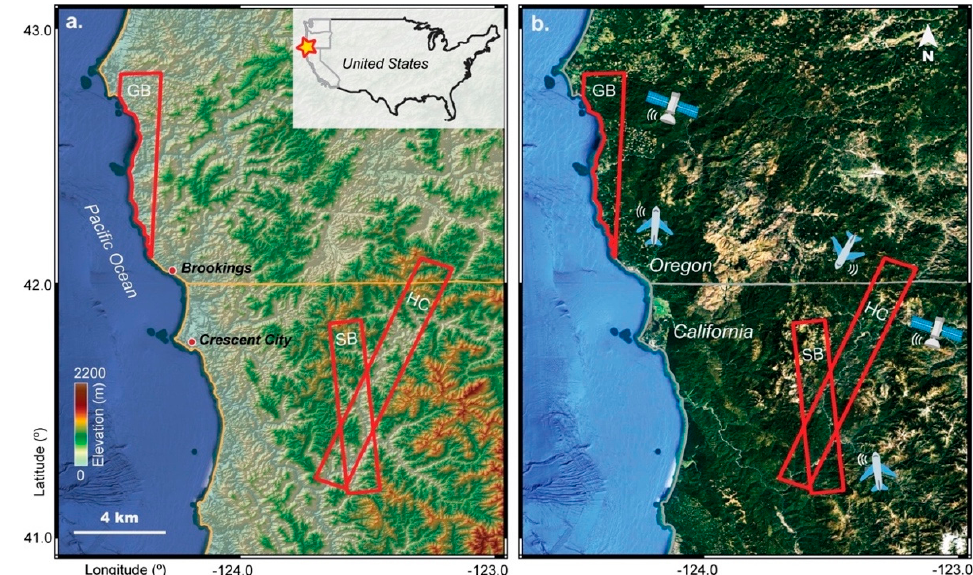
Figure 1. Airborne P-band SAR data coverage. ( a ) Red boxes denote the three regions that are covered by the repeat-pass P-band SAR data and the L-band ALOS-2 SAR imagery. These three regions are annotated as GB (Gold Beach), SB (Somes Bar), and HC (Happy Camp). The red star in the figure at the upper-right corner denotes the geographical location of the study area. The background hillshade map was produced from the National Elevation Datasets [9]. ( b ) A 2020 Google Earth true color image is used as background image to illustrate the vegetation coverage. Both the left-looking airborne P-band SAR and the right-looking satellite L-band SAR data (i.e., the ALOS-2 descending tracks) were acquired for the three target regions. Detailed flying path directions are given in Table 1. Table 1. SAR data and corresponding technical parameters for the three target regions. Target Region